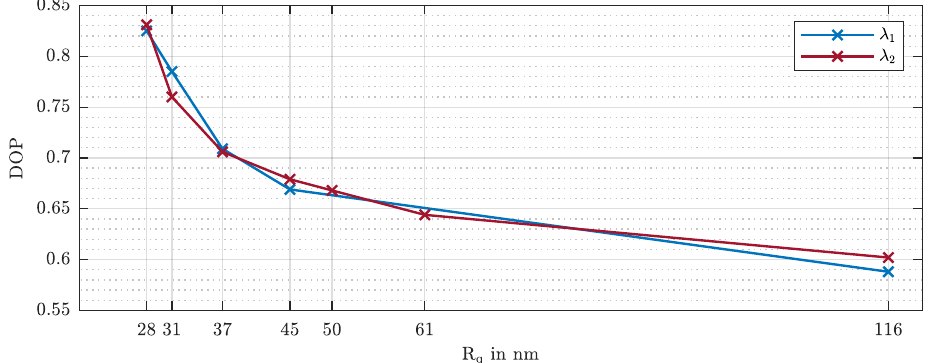
Figure 4. Measured degrees of polarization (DOPs) for λ 1 = 488.0nm [21] and λ 2 =